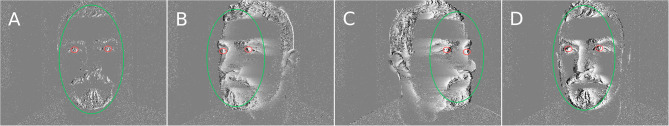
Pose variation experiment. (A) Face tracker is initialized after blink. (B) Subject turns to the left. (C,D) One eye is occluded, but tracker is able to recover.